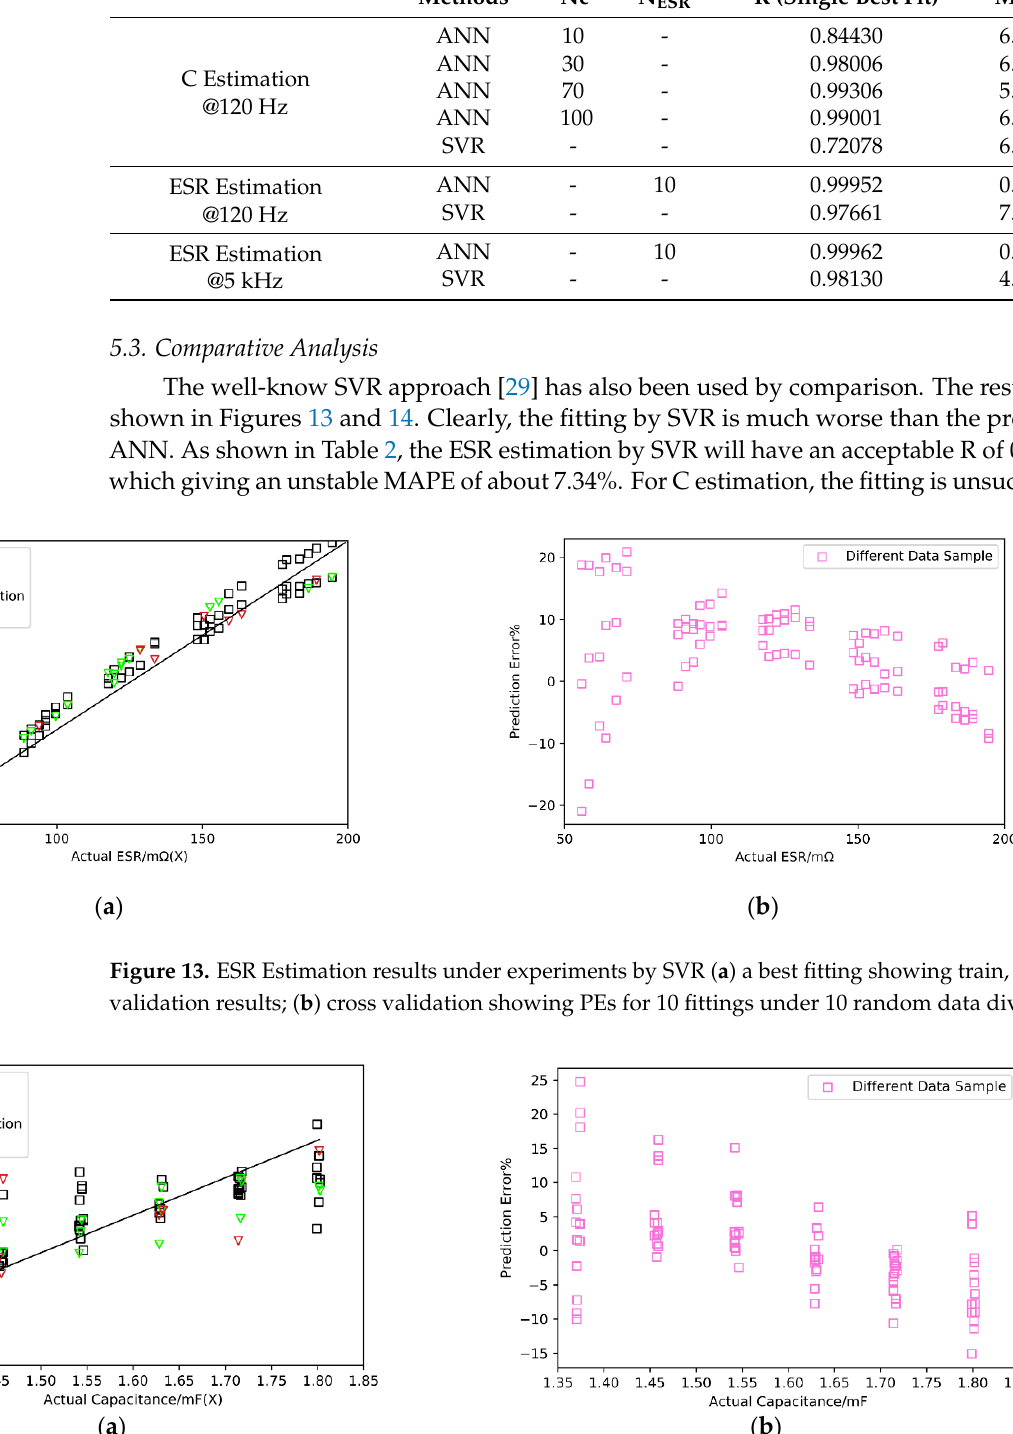
Table 2. Fitting results from experimental data.